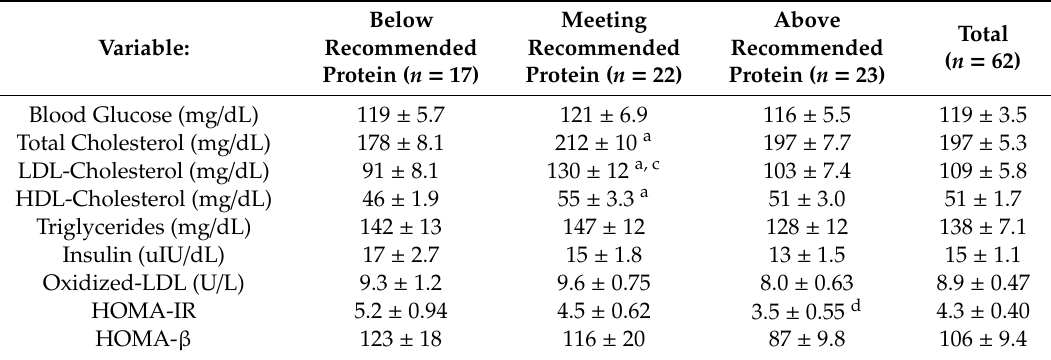
Table 5. Fasting lipid profile and glycemic control.